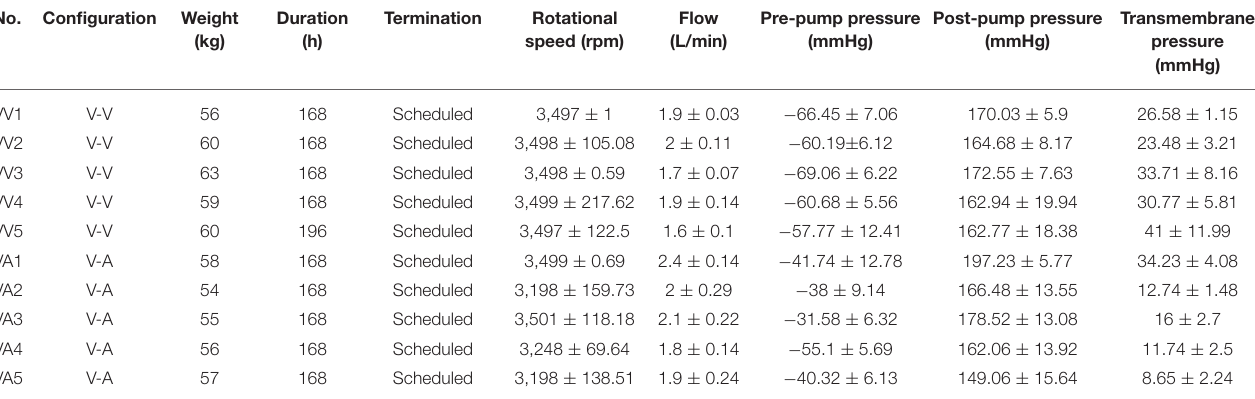
TABLE 1 | Summary of ten